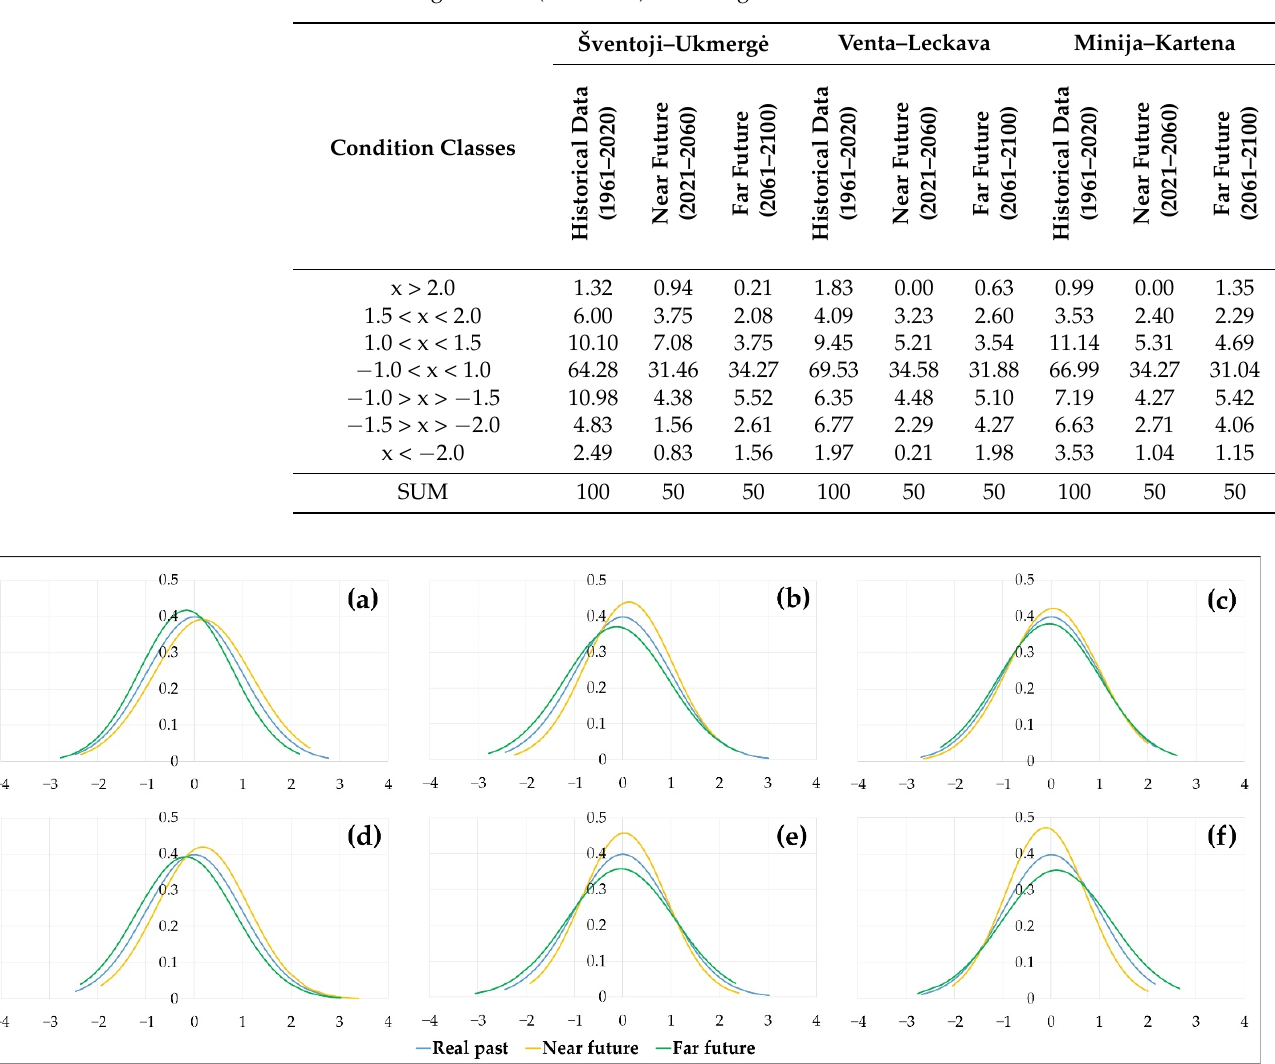
Table 9. Changes of SDI (x in Table) according to RCP 4.5.